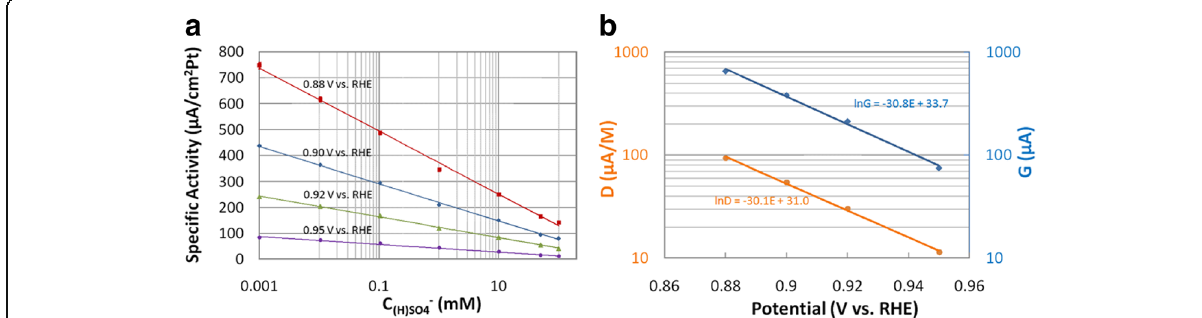
Fig. 3 a Effect of (bi)sulfate ion concentration on ORR-specific activity at various potentials for 30 wt.% PtCo at a sweep rate of 5 mV/s. b Fitted D and G of Fig. 2a vs.